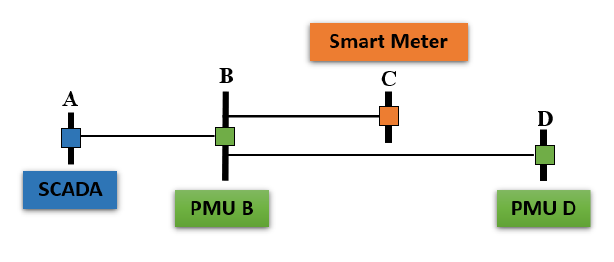
Figure 4. Multiple meter types used in conjunction.